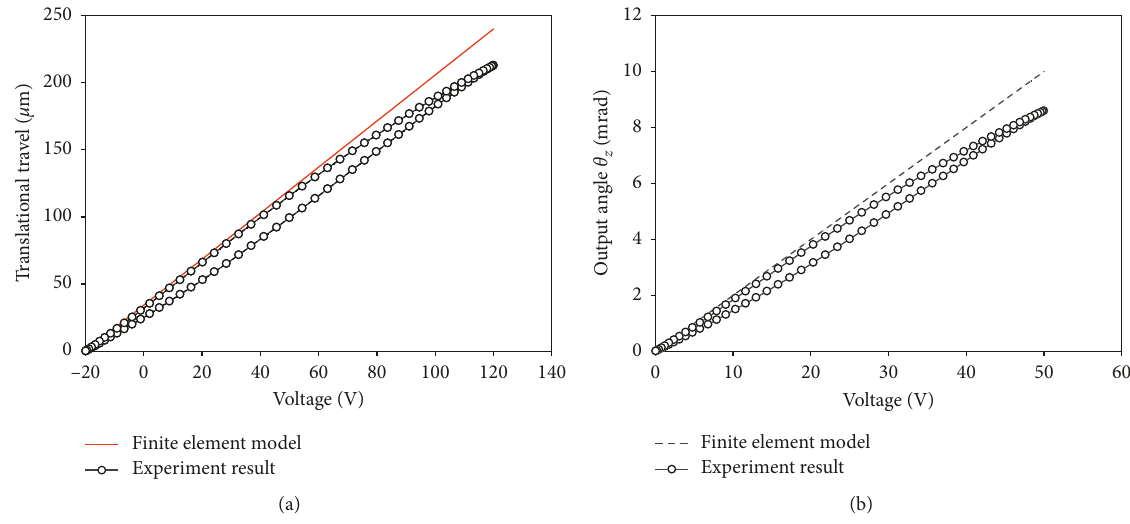
Figure 20: Comparison of the finite element model and experiment results: (a) translational travel; (b) output angle around the Z -axis.